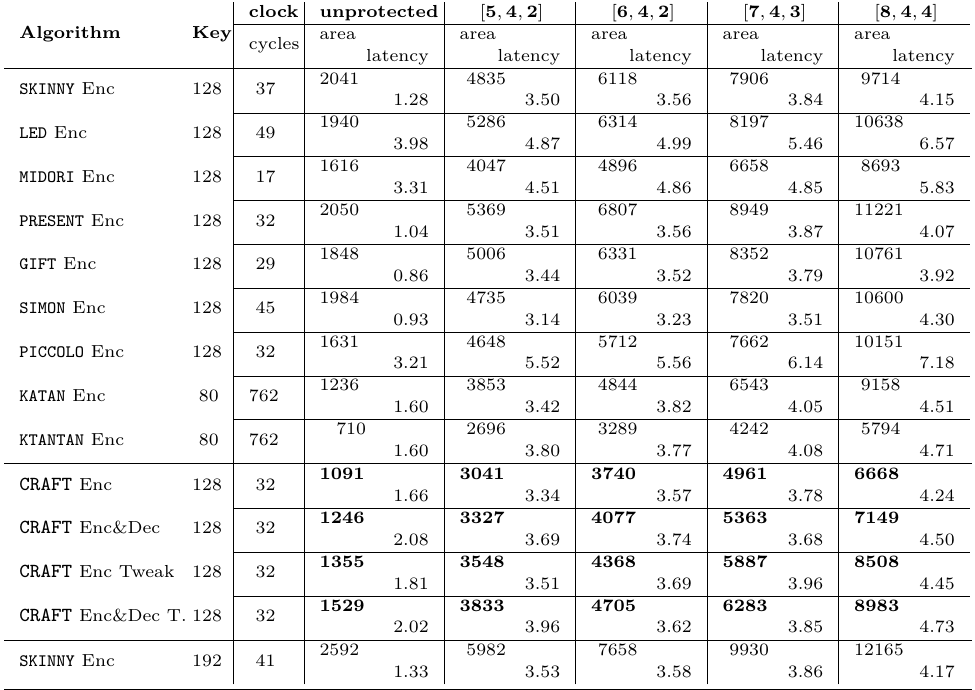
Table 12: Area (GE) and Latency (ns) comparison of round-based implementations considering an M ∗ -bounded multivariate adversary with an [ n, k, d ] code, using a t = d − 1 40 nm commercial ASIC library.